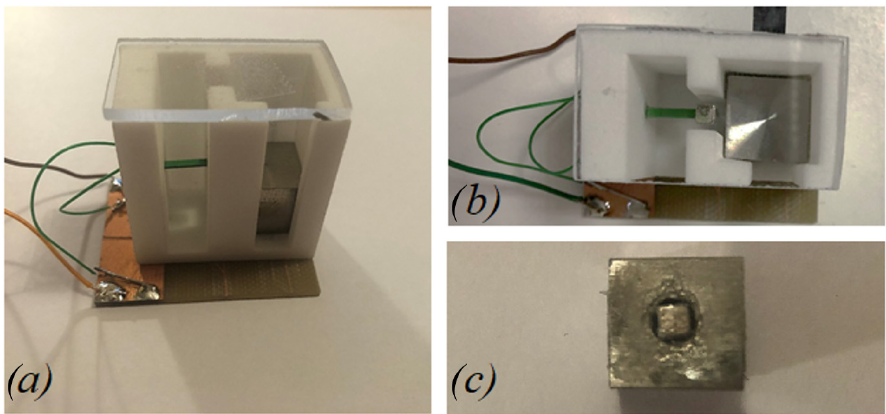
Figure 5. Assembled prototype ( a ) lateral and ( b ) top view. ( c ) Detail of the arrangement of the permanent magnet inside the moving mass.